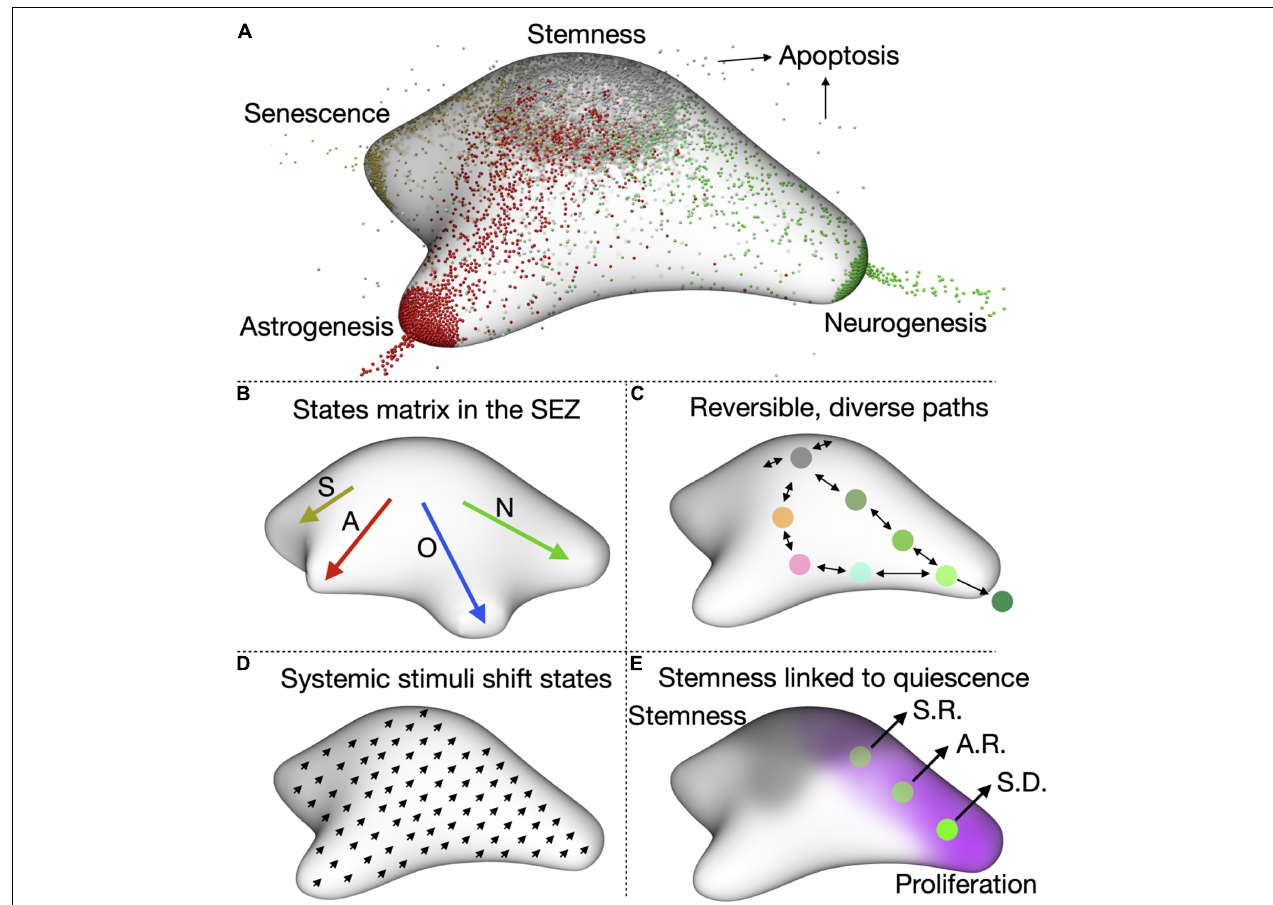
FIGURE 2 | A complete view of aNSC quiescence. (A) Representation of the states matrix for the DG showing the four main outlets, neurogenesis, astrogenesis, senescence, and apoptosis. Their relative weight depends on the age and condition (e.g., stress levels, disease, etc.) of the animal. (B) Representation of the states matrix for the SEZ, in which oligodendrogenesis is also an important outlet. S, senescence; A, astrogenesis; O, oligodendrogenesis; N, neurogenesis. (C) cell can reversibly transition through the matrix space and several paths are possible for the same outcome (in this case, neurogenesis). (D) One of our hypotheses is that systemic stimuli, such as diet of exercise, will shift the cells in the matrix to a slightly different state. This could then affect how they respond to additional stimuli. (E) We also notice that proliferation is inversely correlated with stemness, which suggests that quiescence and stemness could be functionally linked. aNSCs lose self-renewing potential as they continue proliferating. S.R.: symmetric self-renewal, A.R.: asymmetric self-renewal, S.D.: symmetric